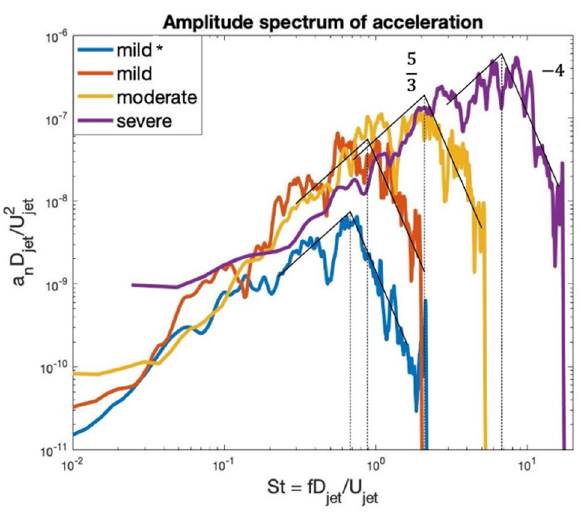
Figure 9. Frequency spectra of wall-normal acceleration from point 4 for “mild*”, “mild”, “moderate”, and “severe” cases.